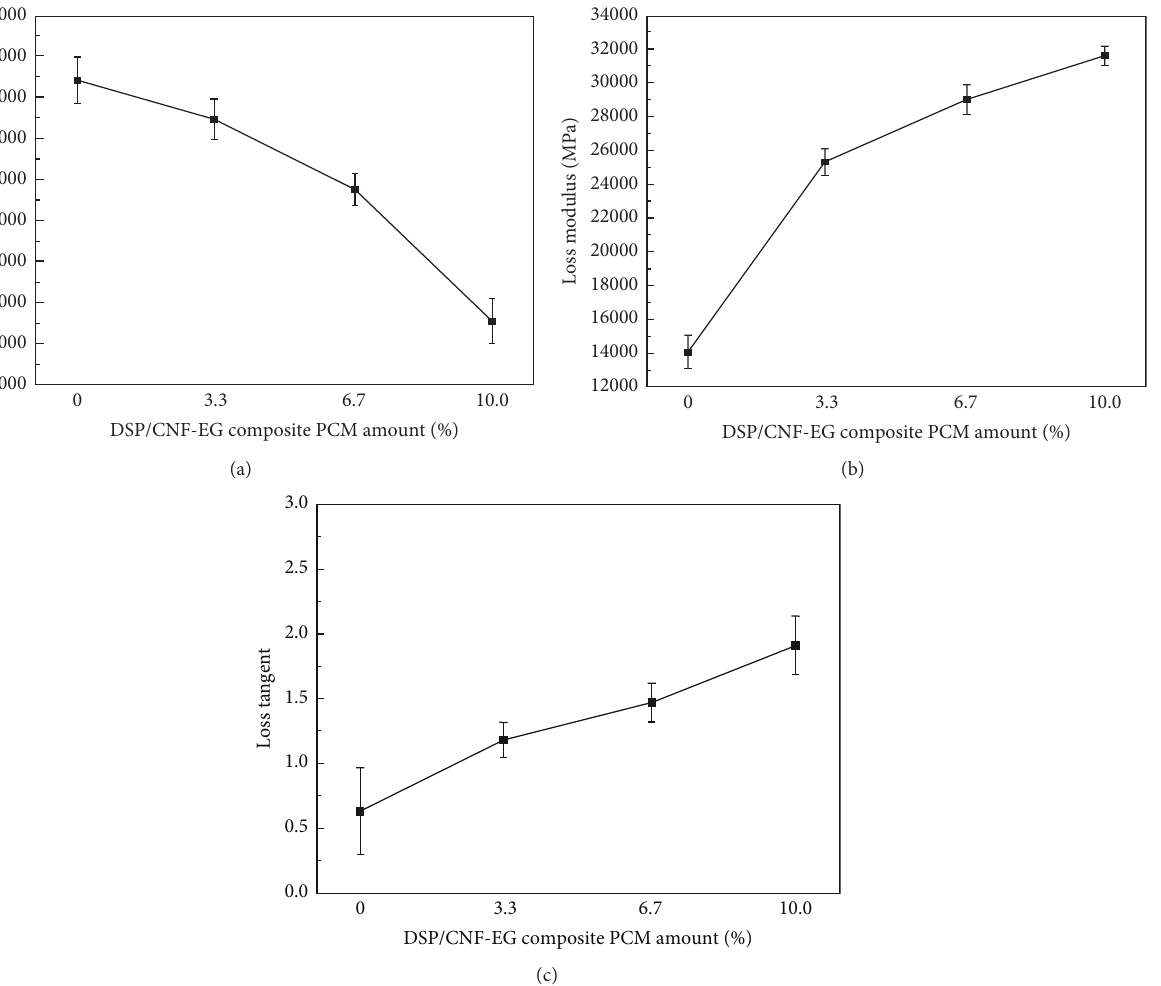
Figure 5: Damping properties of CM and DSP/CNF-EG/CM samples: (a) storage modulus, (b) loss modulus, and (c) loss